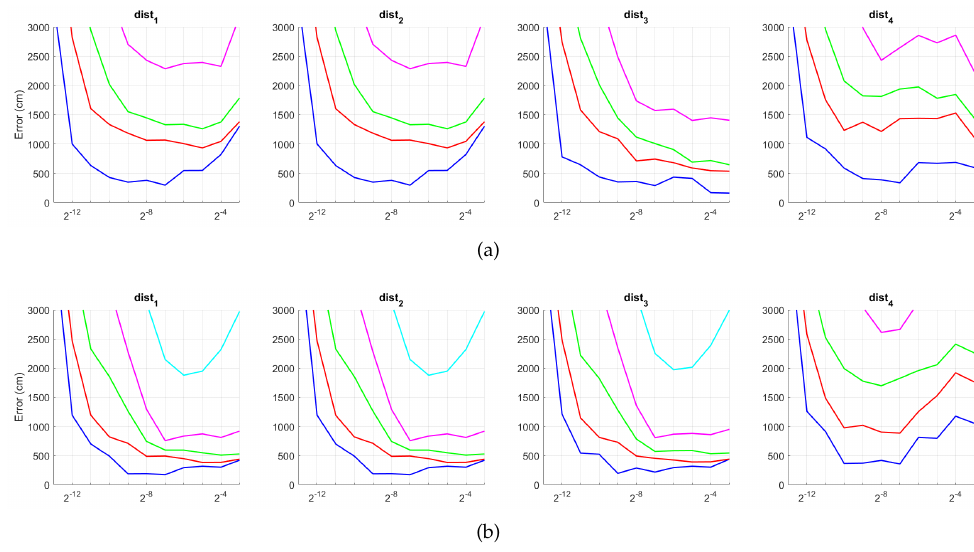
Figure 29. BG average localization error with occlusions: ( a ) no filter and ( b ) homomorphic filtering. Legend: —– Original, —– Occlusion 1, —– Occlusion 2, —– Occlusion 3, —– Occlusion